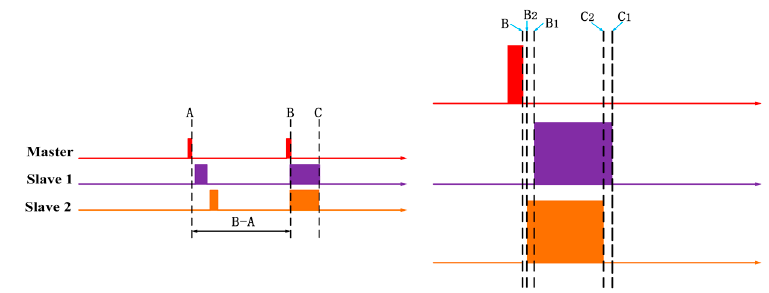
Figure 13. The errors of time synchronization method.